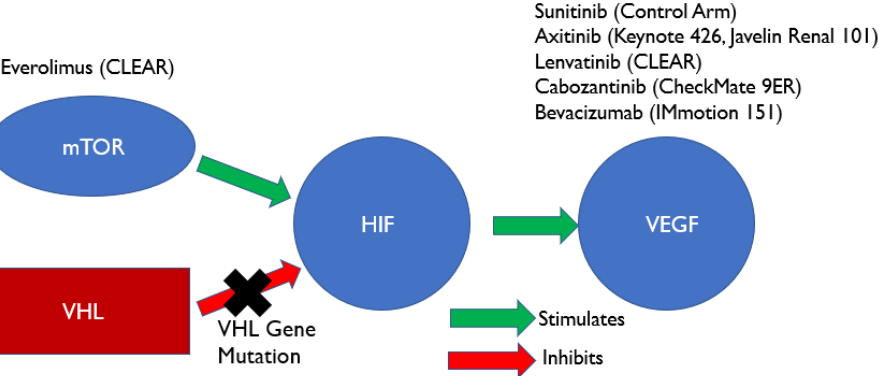
Figure 2. Mechanism of angiogenesis in sporadic RCC. Everolimus–inhibitor of mTOR. Sunitinib– tyrosine kinase inhibitor of VEGF. Axitinib-TKI of VEGF. Lenvatinib–multiple kinase inhibitor of VEGF. Cabozantinib–TKI of RET, MET, and VEGFR2. Bevacizumab–anti-VEGF monoclonal antibody.